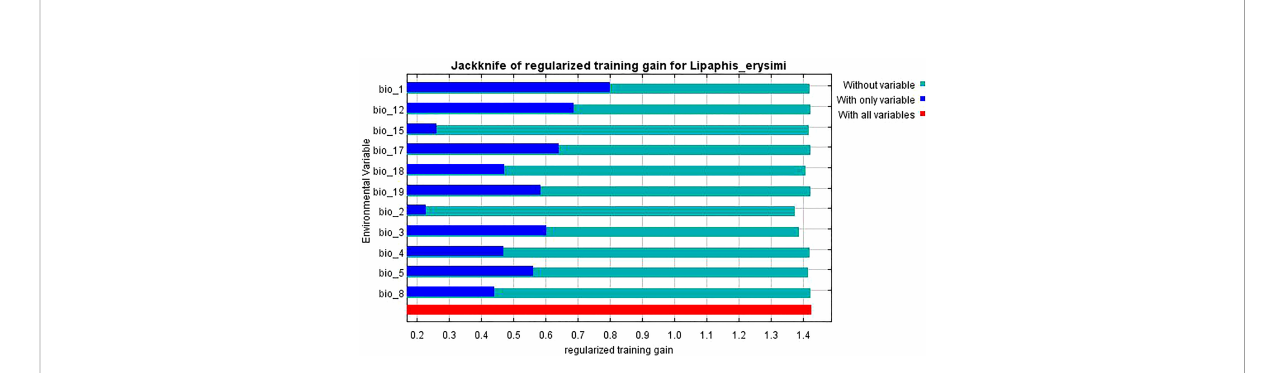
FIGURE 5 Evaluation of environmental variables affecting the distribution of L. erysimi by Jackknife